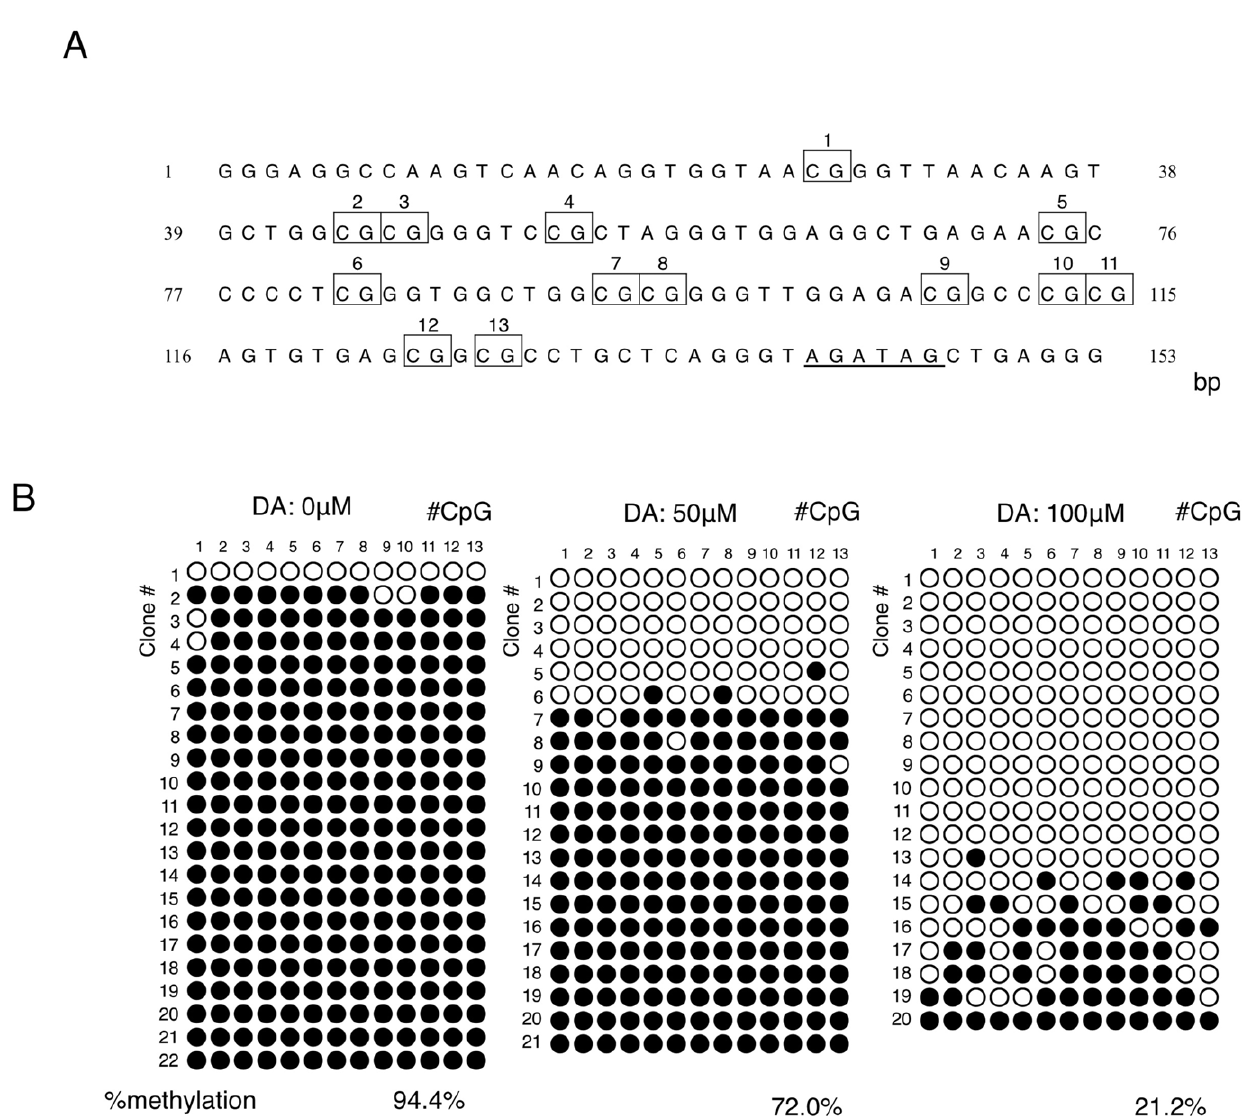
Figure 2. Dopamine induced demethylation of CpG-2. A : Location of CpGs in the second SNCA CpG island. There are 13 CpGs in the CpG-2 region. Each CpG is labeled above according to its positions from the 5 9 end of the sequence. GATA transcription factor recognition sequence is shown with an under bar. B : Bisulfite sequence analysis of the CpG-2 region. Dopamine (DA; 0, 50, and 100 m M) was added to 293 cells. DNA was purified and bisulfite sequence analysis was performed. At least 20 clones from each dopamine-treated group were analyzed. Open circles indicate unmethylated CpGs, whereas closed circles indicate methylated CpGs. The degree of methylation was calculated as methylated CpG/total CpG and shown below (% methylation).